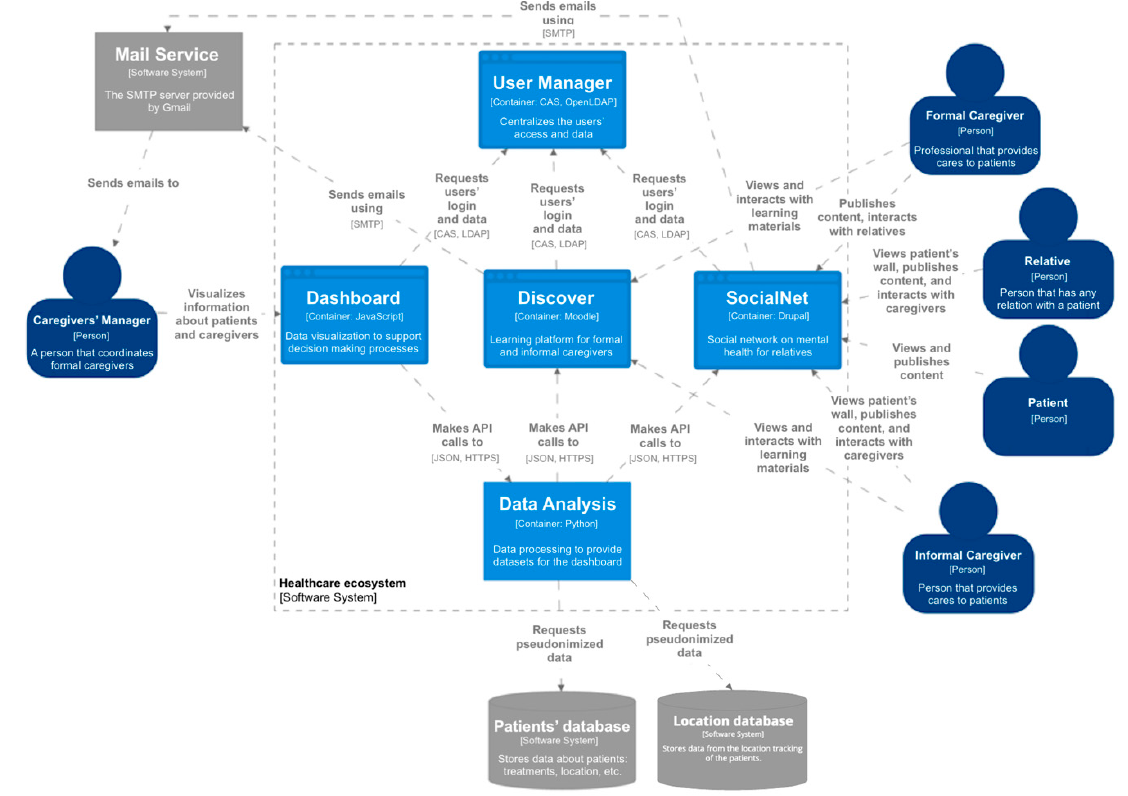
Figure 8. Healthcare ecosystem architecture in C4 Model.